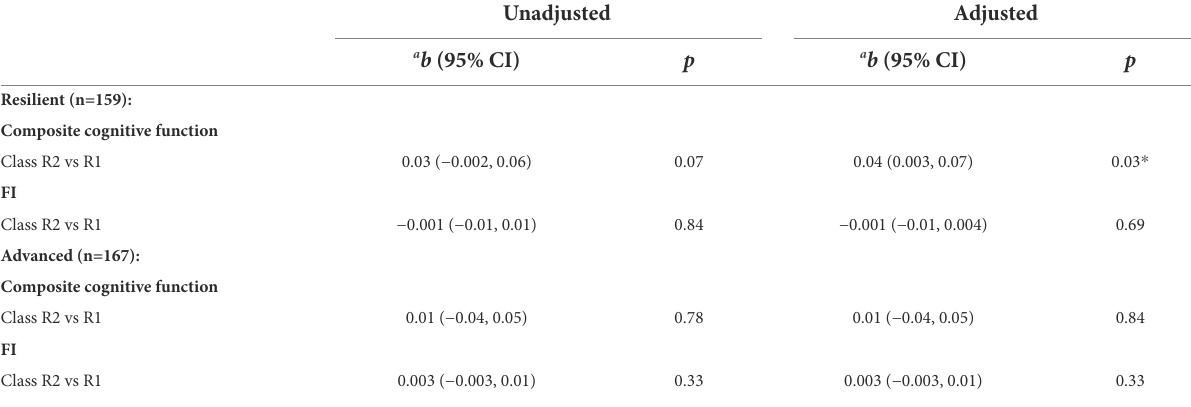
TABLE 2 Linear mixed models examining the association between health-related profiles in brain aging and change in composite cognitive function and frailty index (FI). Unadjusted Adjusted a b (95% CI) p a b (95% CI) p